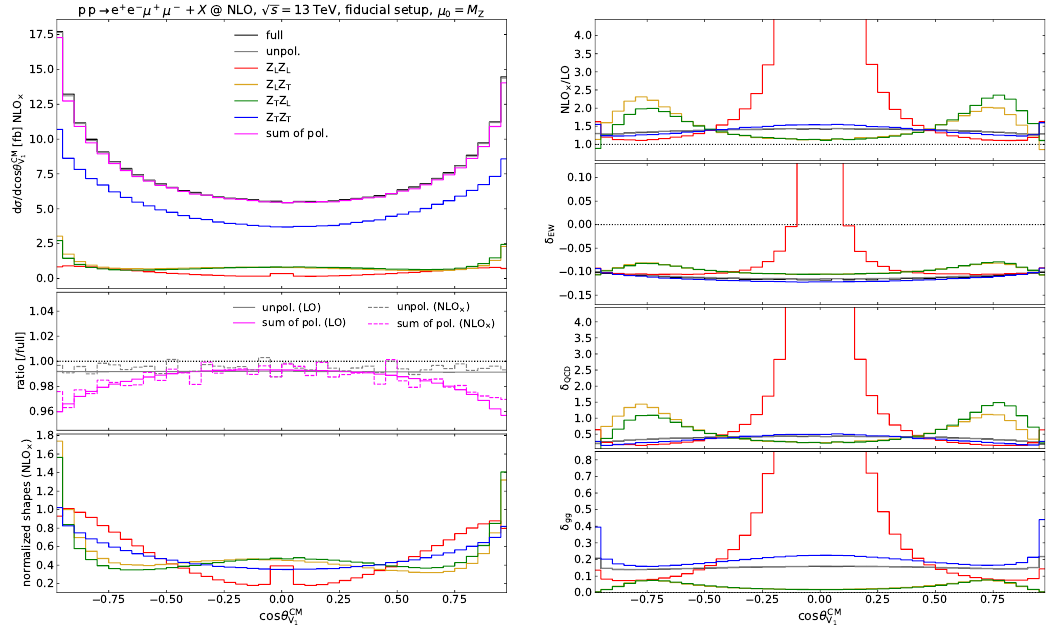
Figure 11 . Distributions in the scattering angle of the Z boson decaying into e + e − in the four- lepton CM frame computed w.r.t. the four-lepton-system direction in the LAB frame. Same struc- ture as in figure